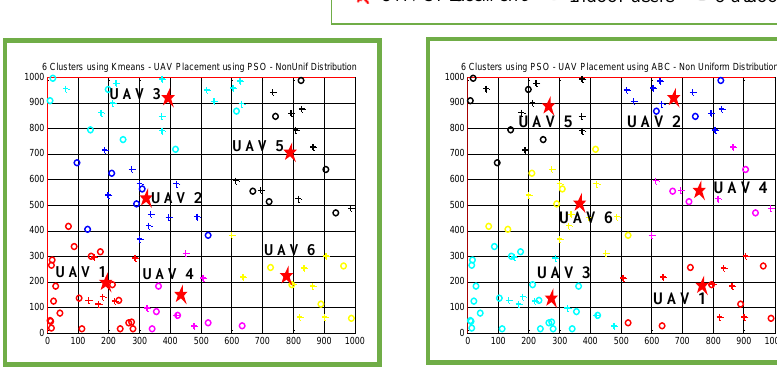
UAVs Placement Indoor users Outdoor users